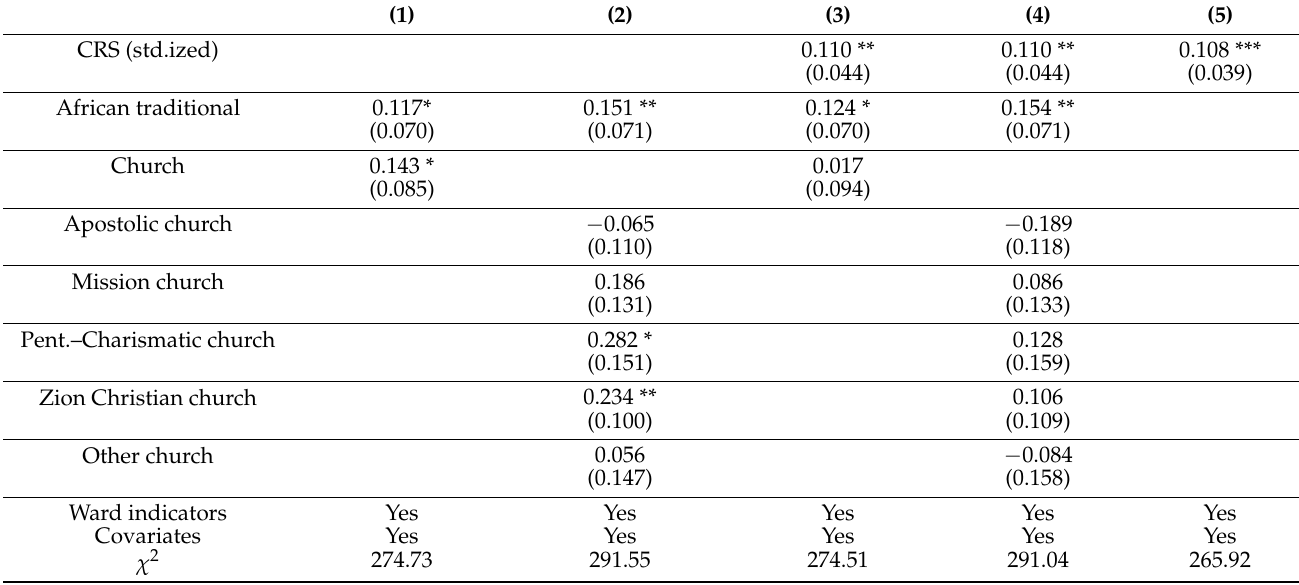
Table 6. Estimation results ordered probit model.